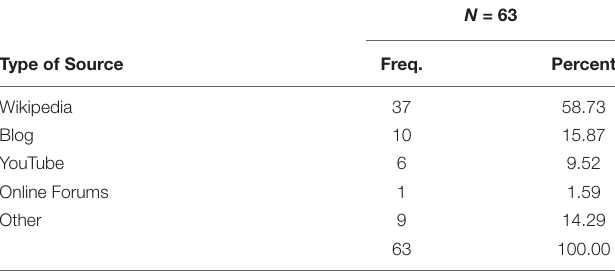
TABLE 4 | Number of accessed social media websites by subtype and per task 1 .